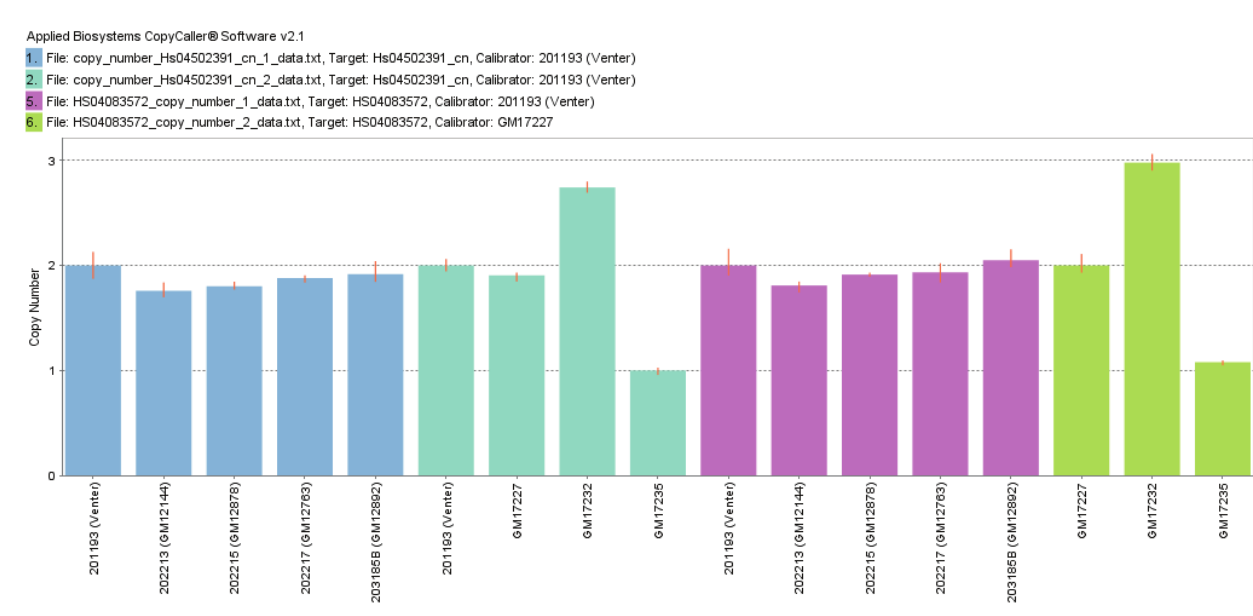
figshare: Nanopore reads and alignments, doi: http://dx.doi.org/ 10.6084/m9.figshare.1289717 27 Raw nanopore reads and alignment files are available at the NCBI Sequence Read Archive, accession SRP051851